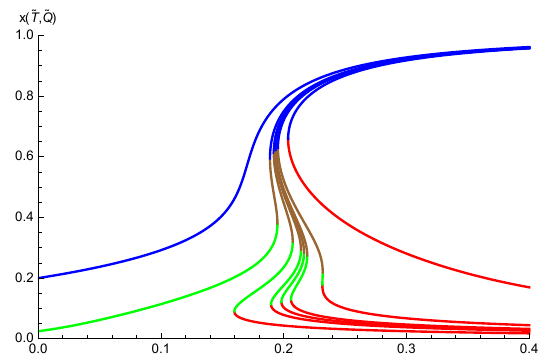
Figure 2. Plots of x ( ~ T; ~ Q ) against ~ T for various values of ~ Q with ~ a = 0 : 05, where x ( ~ T; ~ Q ) is the locally stationary point of ~ F ( x ). From left to right, ~ Q = 0 : 600 (Region I), 0 : 450 (Region II), 0 : 415 (Region III), 0 : 400 (Region IV), 0 : 395 (Region IV), 0 : 390 (Region IV), 0 : 370 (Region IV) and 0 : 200 (Region V). Since thermally stable phases have @x=@ ~ T > 0, the BI BHs on blue and green segments of the curves are thermally stable. We denote the BI BHs on blue segments by Large BH (or BH if there is no green segment on the curve) and these on green segments by Small BH. The BI BHs on red and brown segments are denoted by Intermediate BH, which are thermally